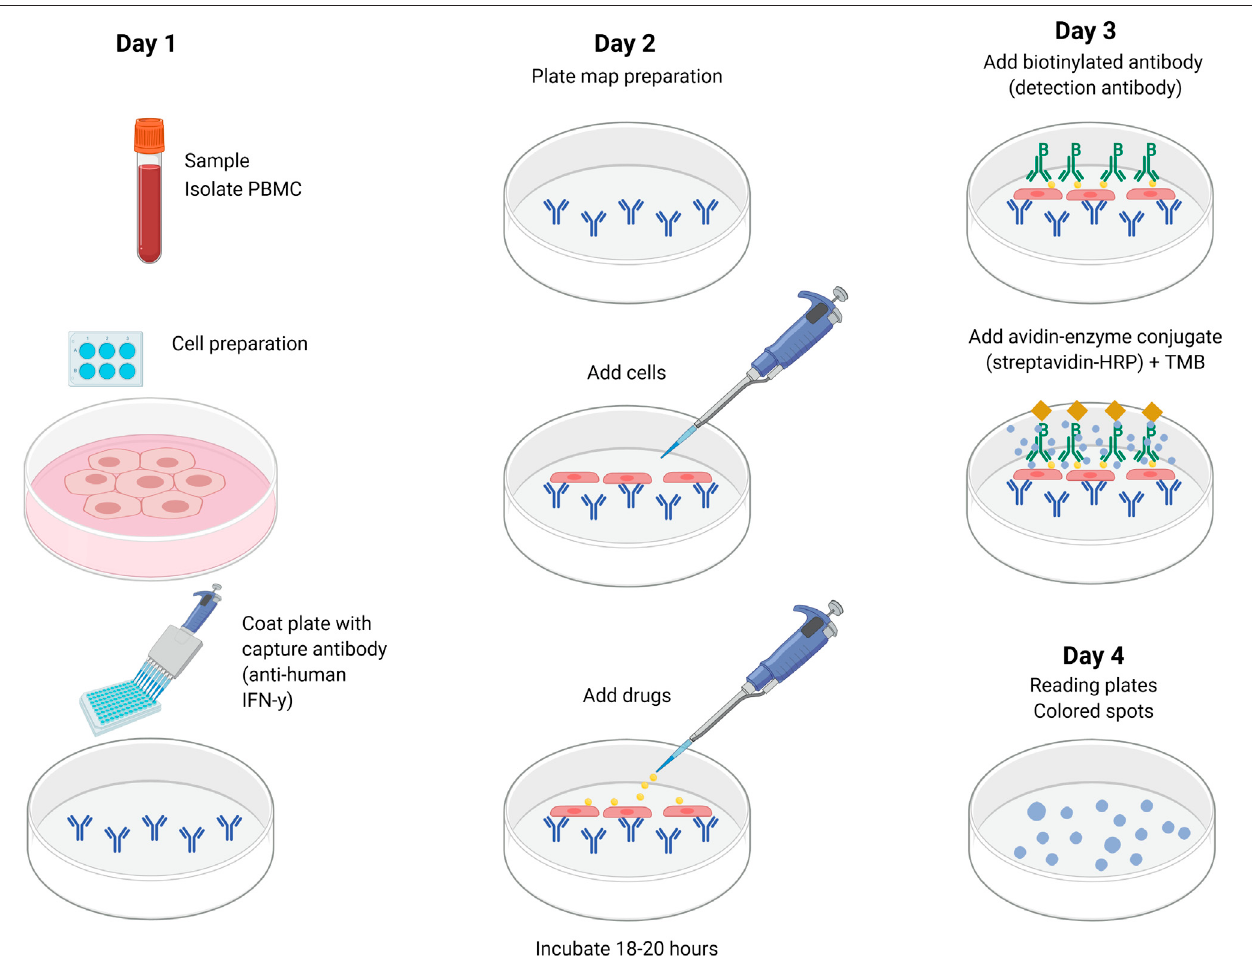
FIGURE 3 | Detection of cytokine secretion using ELISpot. Cytokine-speci fi c coating antibody is added and incubated overnight at 4 ° C. The plate is washed and PBMCs and drug(s) are added and incubated for 18 – 20 h at 37 ° C. The following day, the plate is washed again and biotin-conjugated detection antibody is added and incubated for 2 h at room temperature. After another wash, streptavidin-bound enzyme is added and incubated for 1 h at room temperature. After the last wash, substrate isadded (BCIP-NBTorTMB).Spot developmentismonitoredfor ∼ 15 min (in dark).Theplateiswashedand lefttodry overnight fora fi nalreading on the fourth day. BCIP-NBT, 5-bromo-4-chloro-3-indolyl phosphate (BCIP)/nitro blue tetrazolium (NBT); ELISpot, enzyme linked ImmunoSpot; PBMC, peripheral blood mononuclear cells; TMB, tetramethyl benzidine.